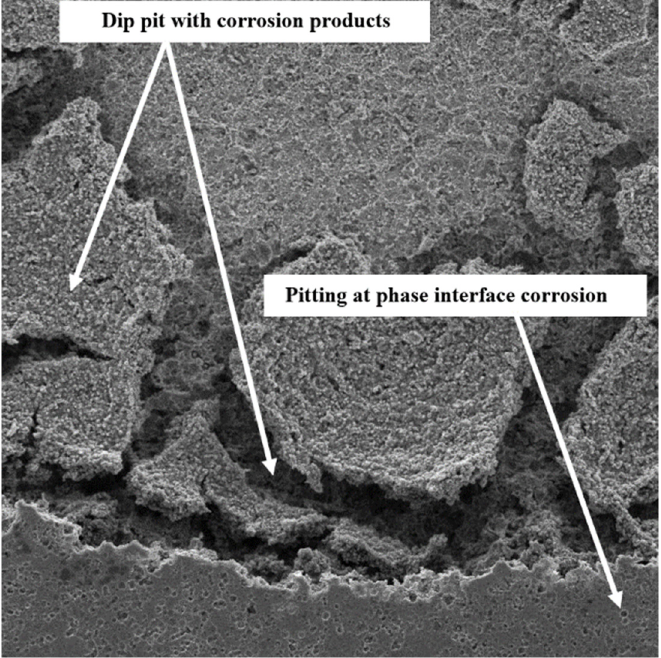
Figure 11. SEM image (1000×) of the uncoated specimen’s surface following the corrosion test.